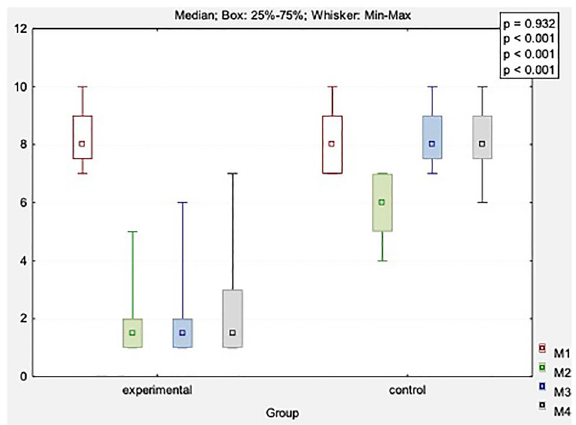
Figure 2. Comparison of changes in pain scores (VAS) obtained in four measurements between study and control group. M1, before treatment; M2, after treatment; M3, 1 month after study; M4, 3 months after study.